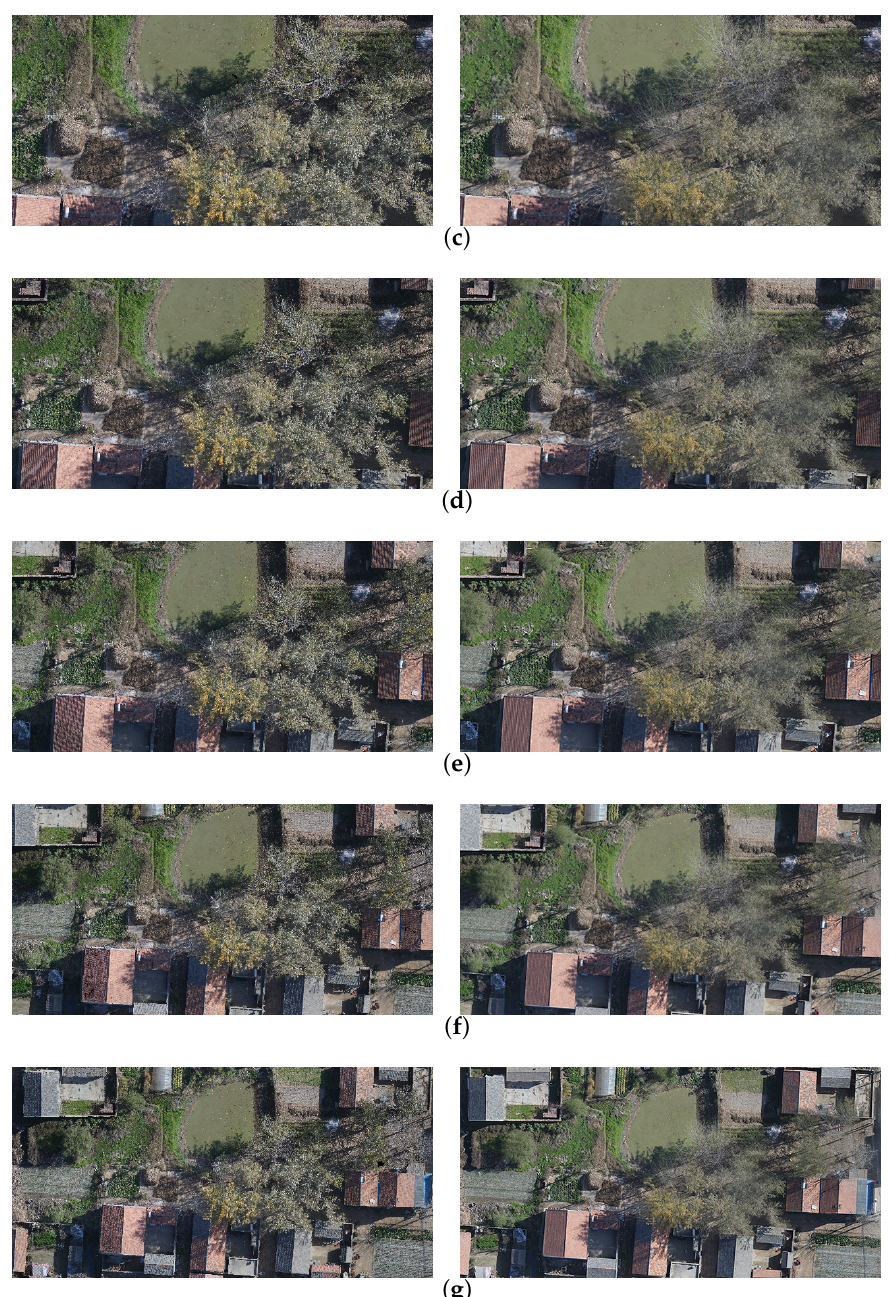
Figure 21. Parts of digital orthophotos with a constant 624 × 312 pixels generated from different spatial resolutions. The left column is the results generated by TDM, and the right is the results generated by Pix4D. ( a ) L p is 4 cm. ( b ) L p is 6 cm. ( c ) L p is 8 cm. ( d ) L p is 10 cm. ( e ) L p is 12 cm. ( f ) L p is 14 cm. ( g ) L p is 16